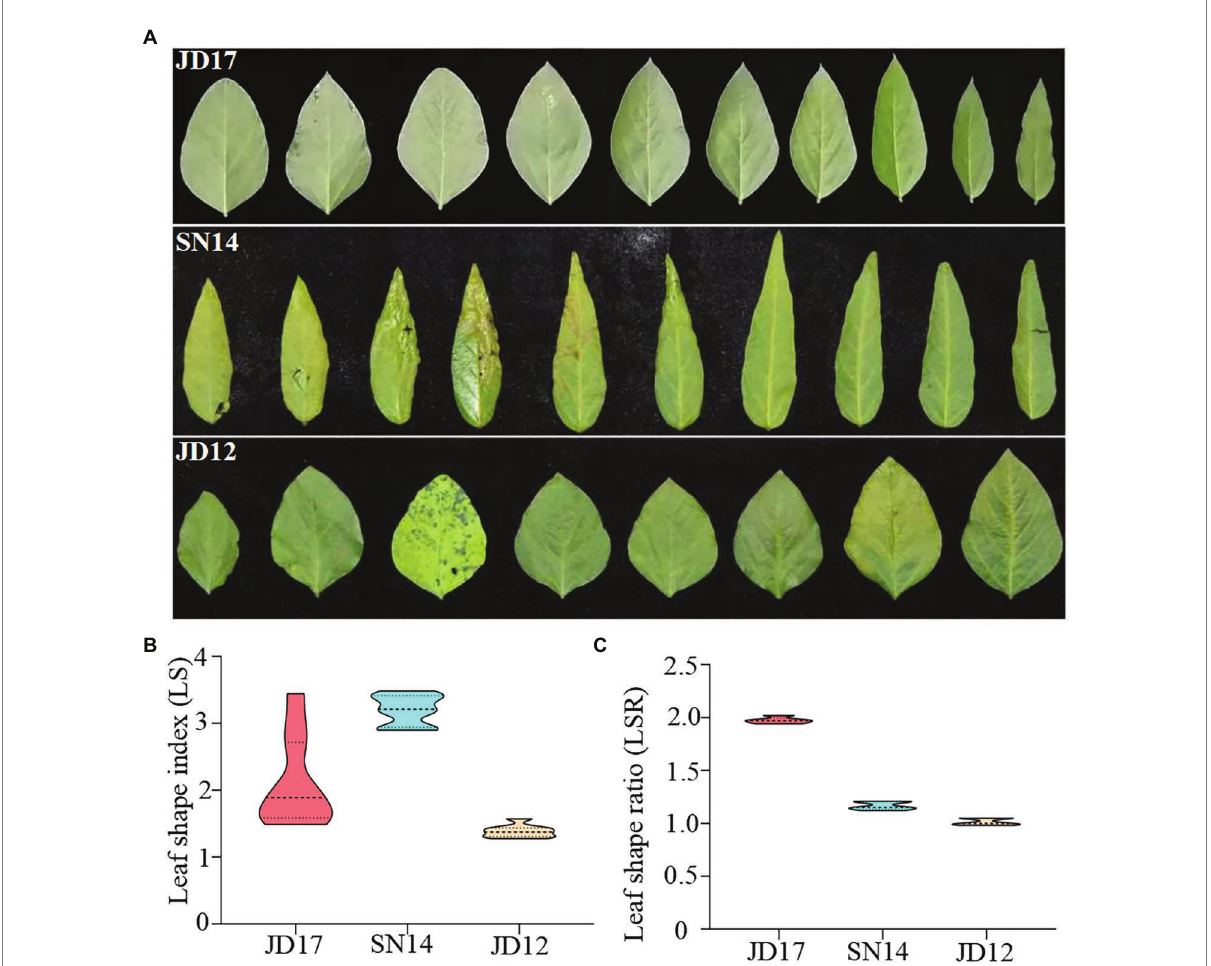
FIGURE 1 Phenotypic variation in leaf shape among the three parental genotypes at the developmental stage of R6. (A) Trifoliate leaves of the first ten leaves (1 st trifoliate leaves on the left); (B) the distribution of leaf shape index (LS); and (C) leaf shape ratio of whole